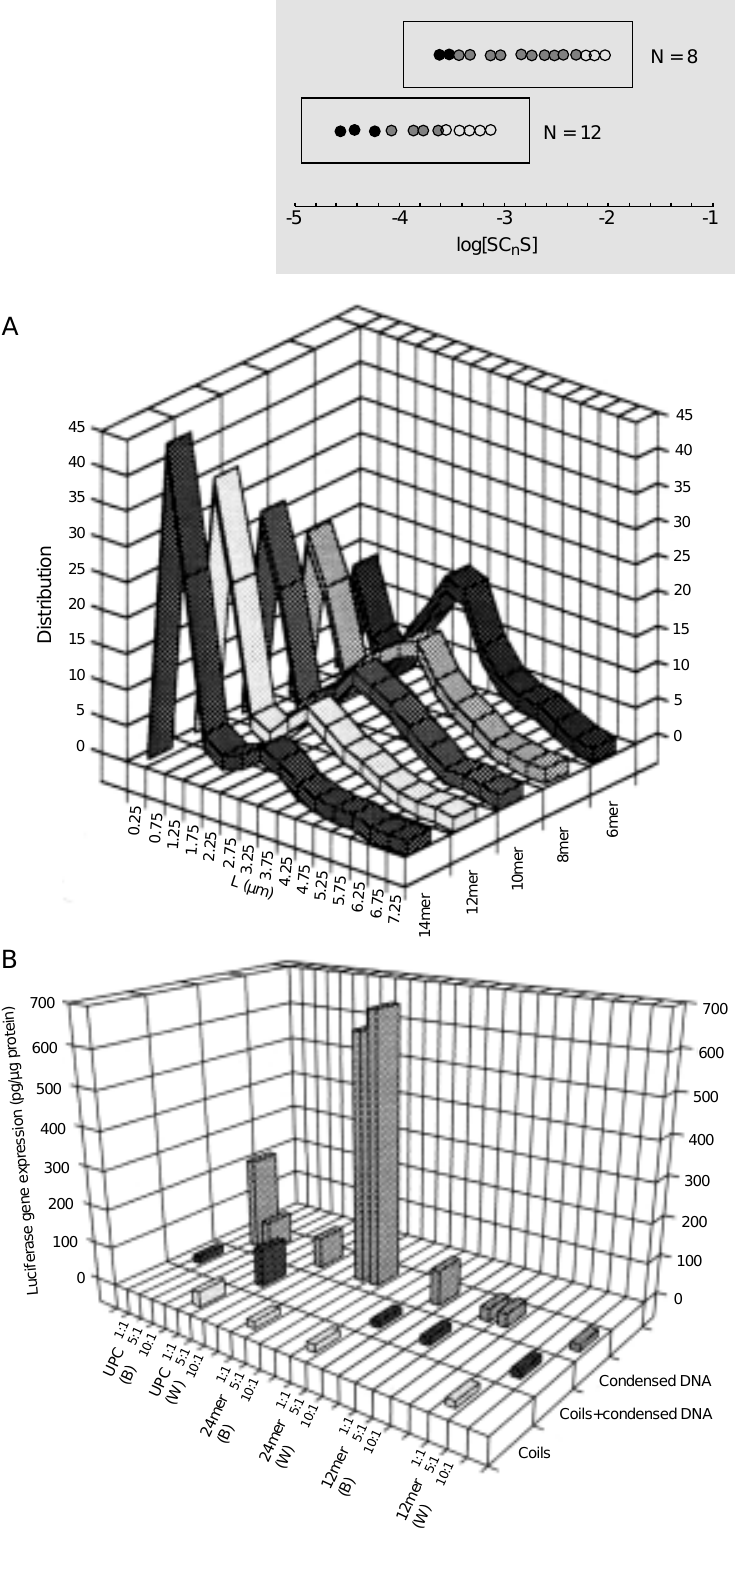
Condensed DNA Coils+condensed DNA A polycation compacts DNA in a similar way as a surfactant aggregate Coils